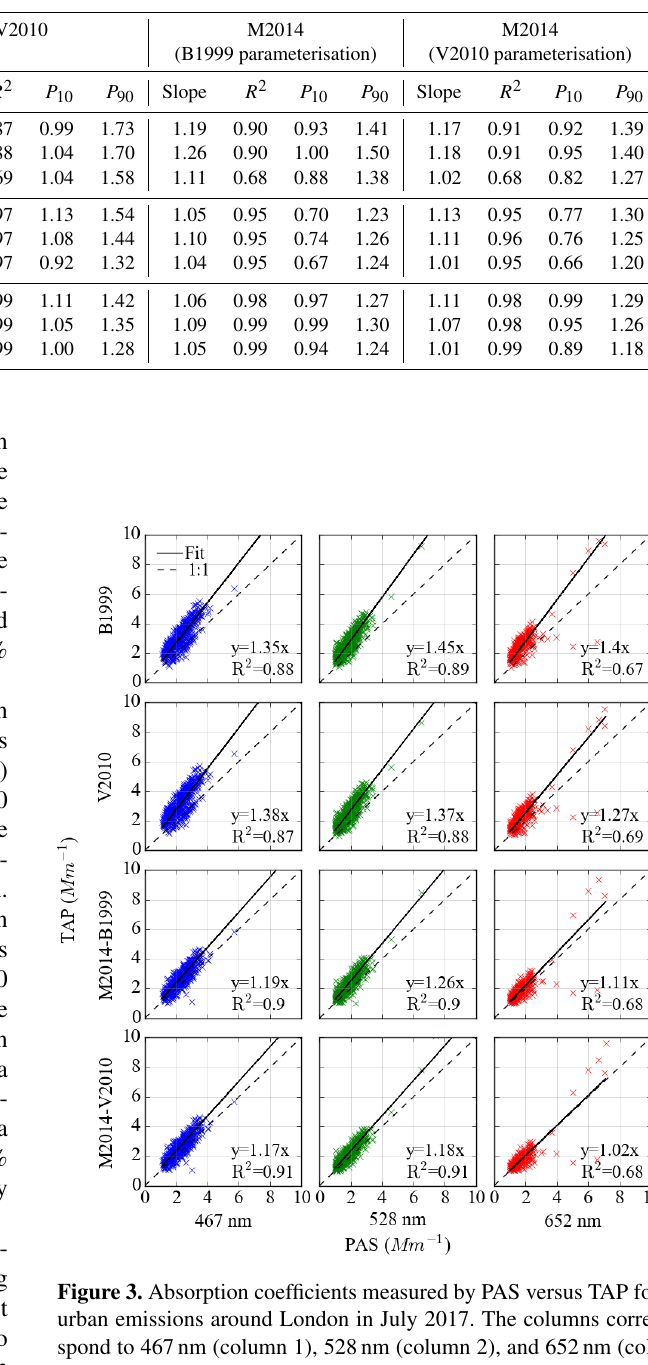
Table 2. A summary of the slopes ( R abs ) between PAS and TAP absorption coefficients. Correlation coefficients ( R 2 ) are also provided. P 10 and P 90 are the 10th and 90th percentiles of each dataset. All absorption coefficients correspond to >1Mm − 1 . All linear regressions were forced through the origin.